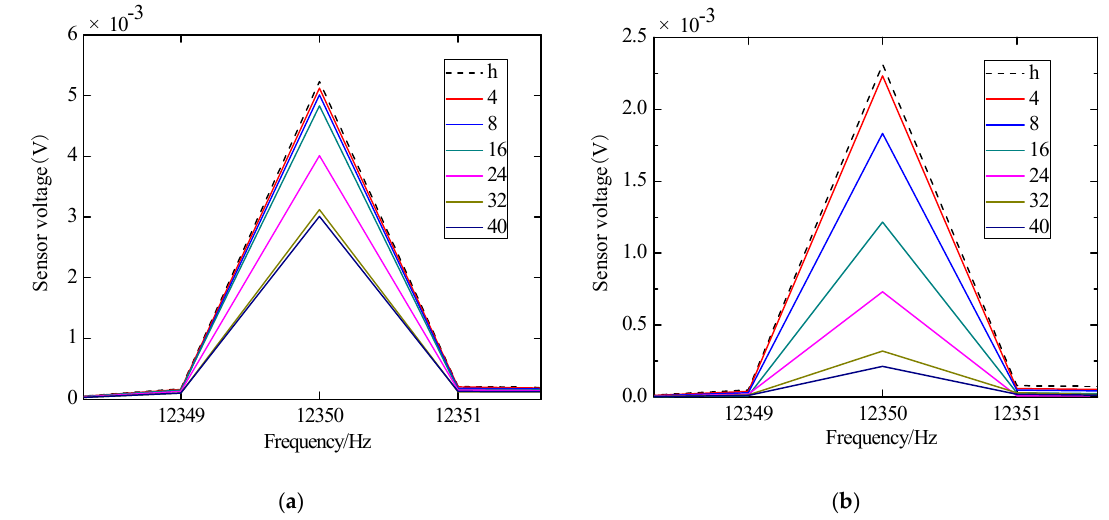
Figure 13. Frequency domain diagram of sine signals received by sensors of specimen JD-1. ( a ) S1-S2; ( b ) S1-S3.